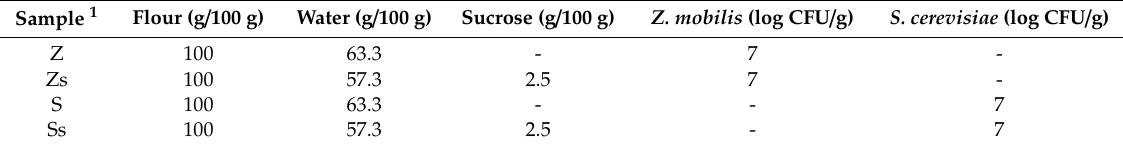
Table 1. Dough sample identifications and formulations: ingredients are expressed on flour basis, while inocula on dough